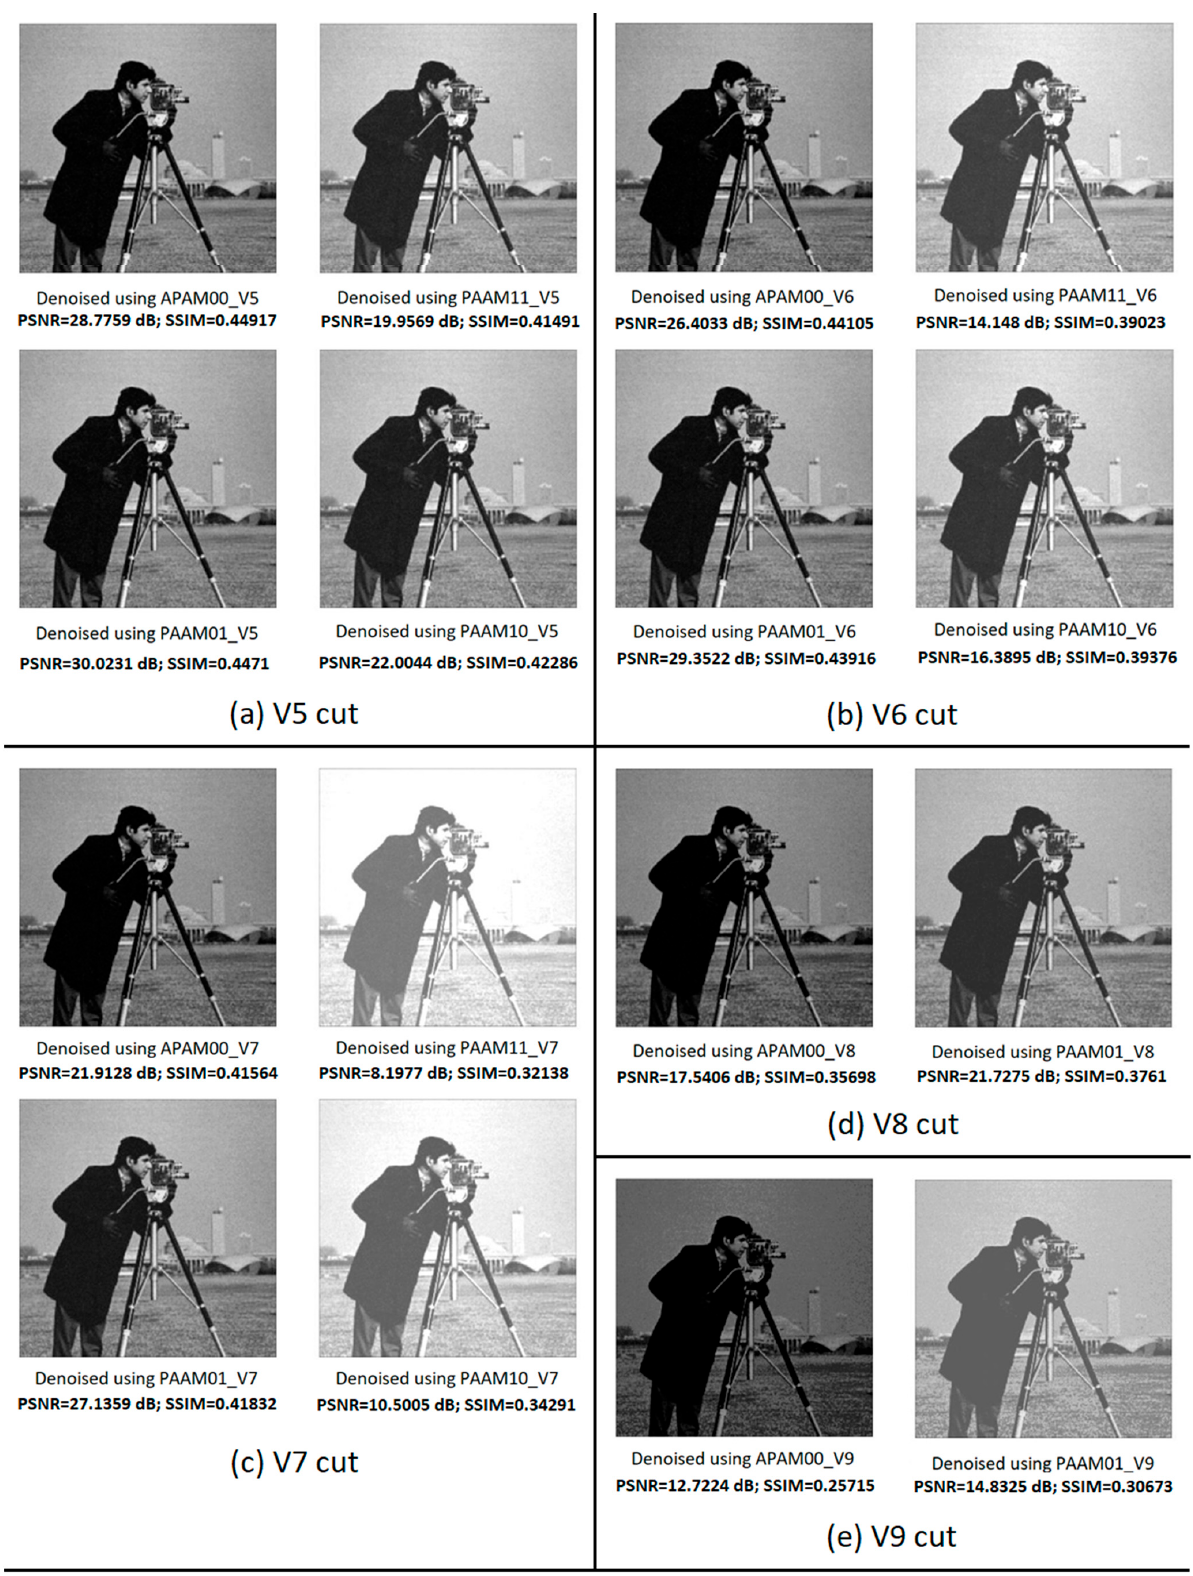
Figure 7. Denoised images obtained using approximate array multipliers resulting from: ( a ) V1 cut; ( b ) V2 cut; ( c ) V3 cut; and ( d ) V4 cut.